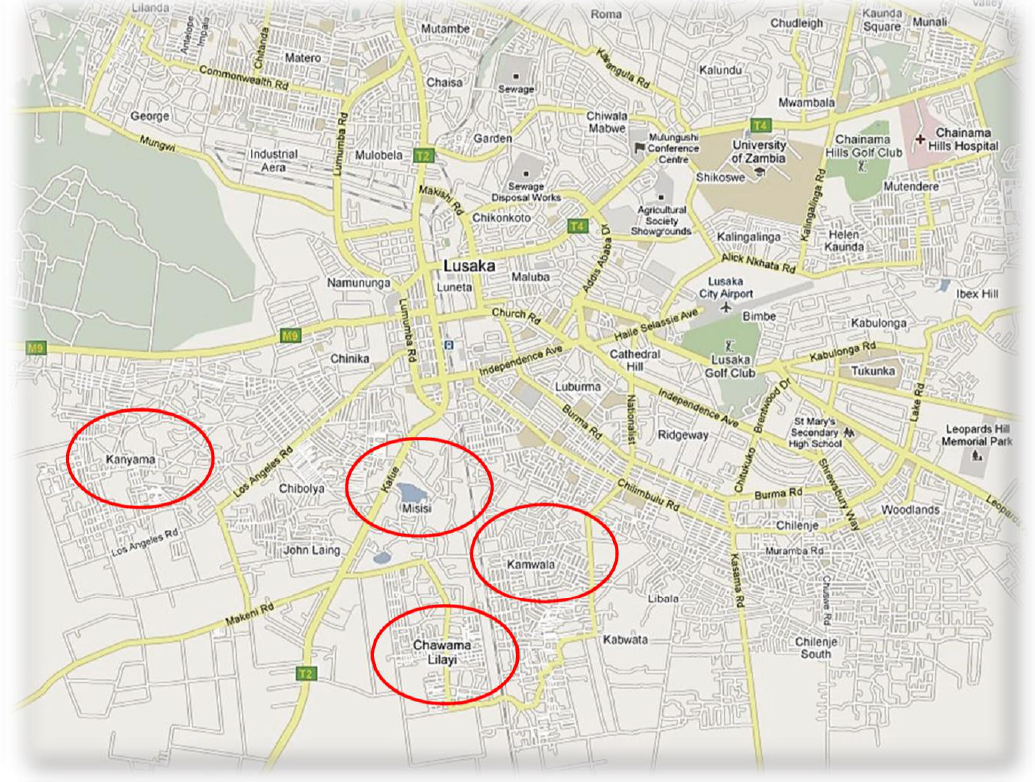
Figure 1. Map of Lusaka, Zambia with the four compounds indicated.